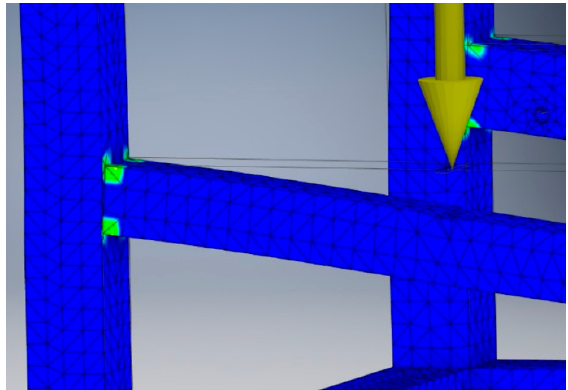
Figure 3. Stress simulation for the frame (von Mises stress).